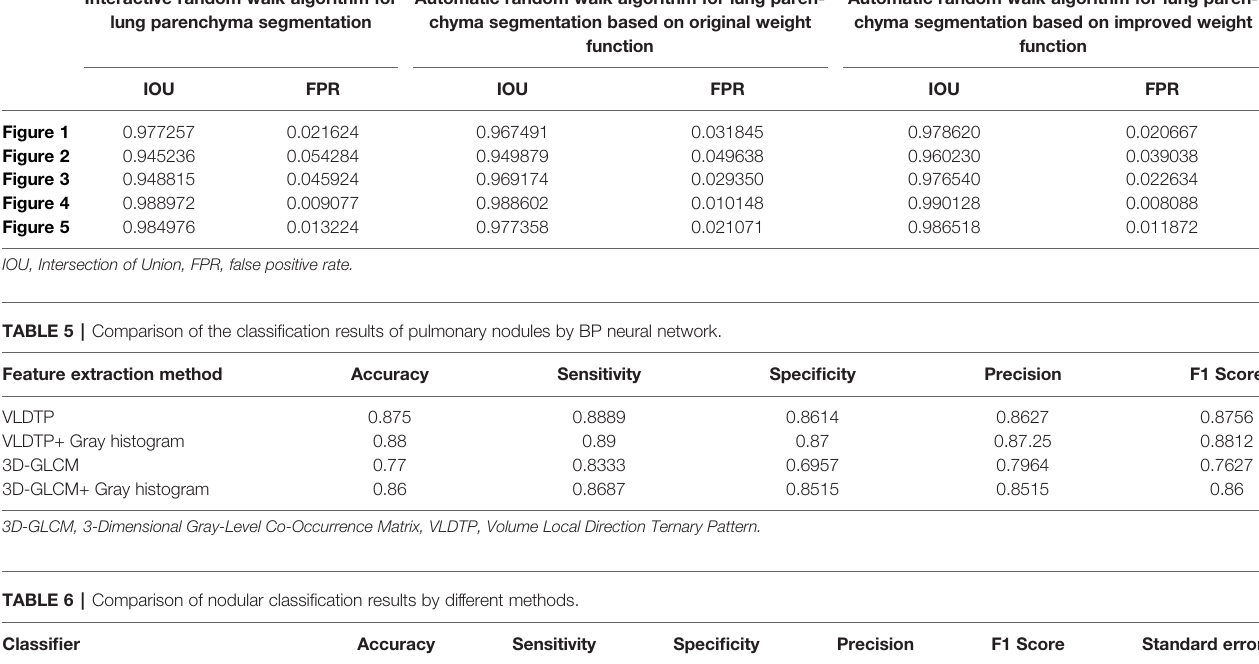
TABLE 4 | Segmentation and contrast data of lung parenchyma. Interactive random walk algorithm for Automatic random walk algorithm for lung paren- Automatic random walk algorithm for lung paren- lung parenchyma segmentation chyma segmentation based on original weight chyma segmentation based on improved weight function